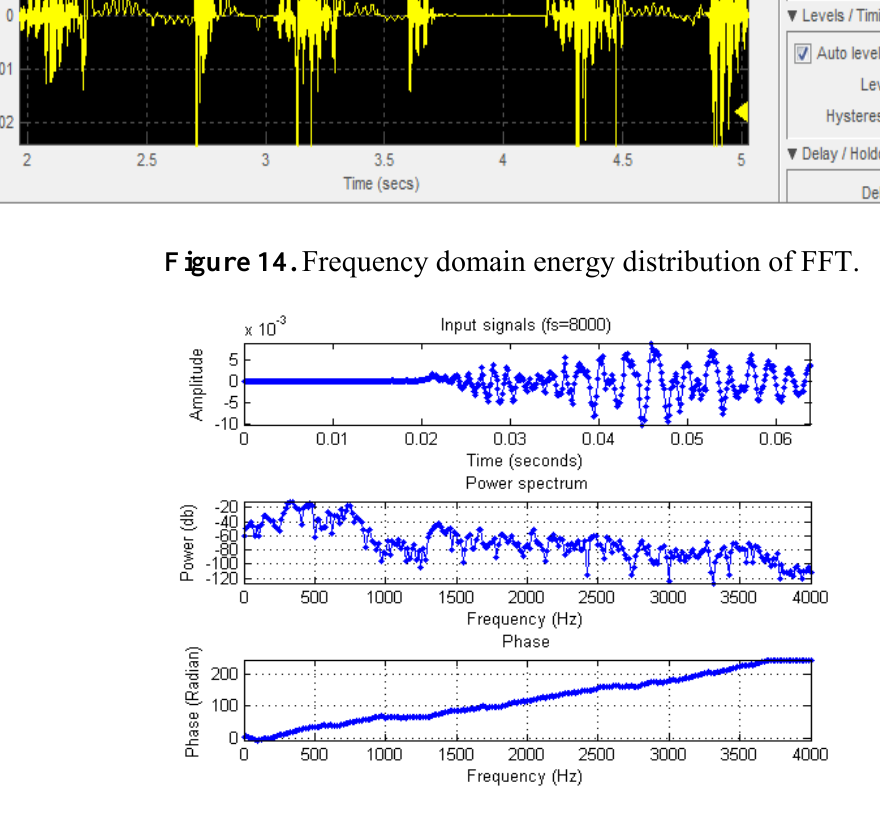
Figure 15. Frequency to mel-scale of frequency